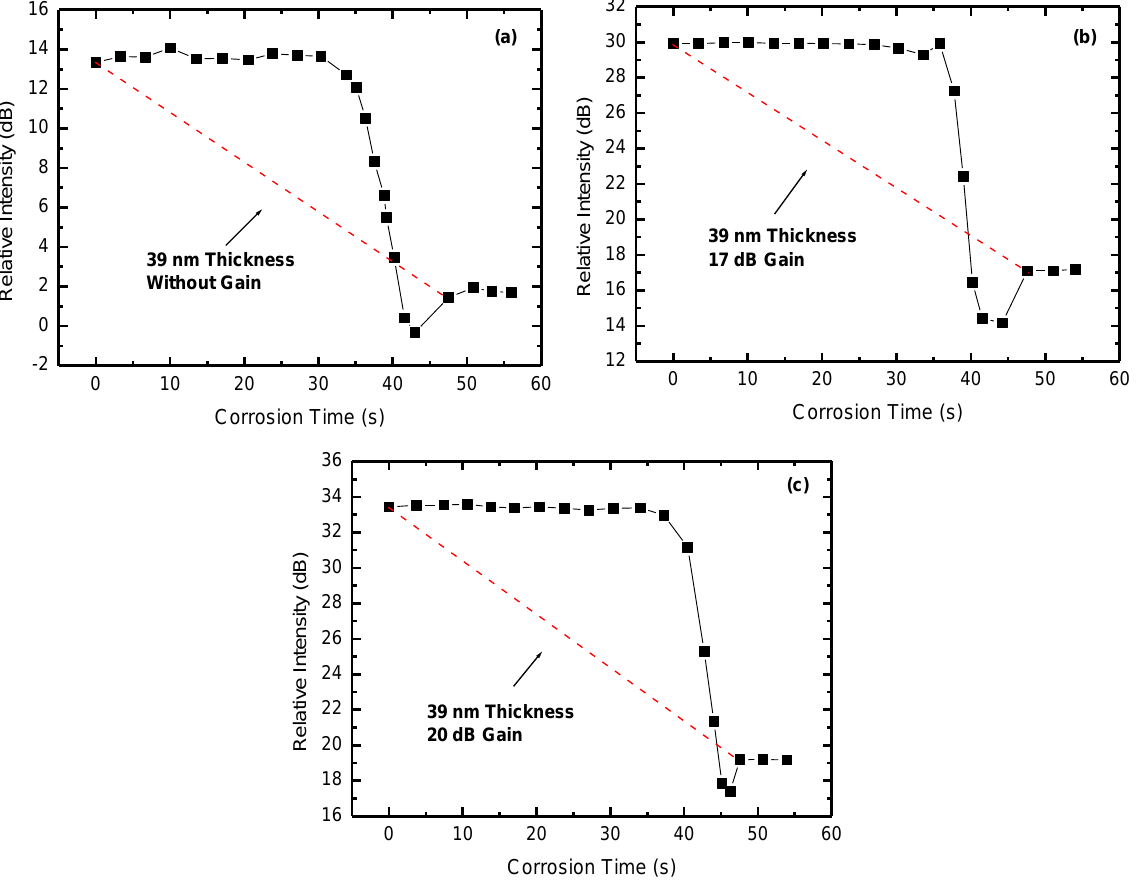
Figure 5. OTDR relative intensity as a function of the Al film corrosion time for